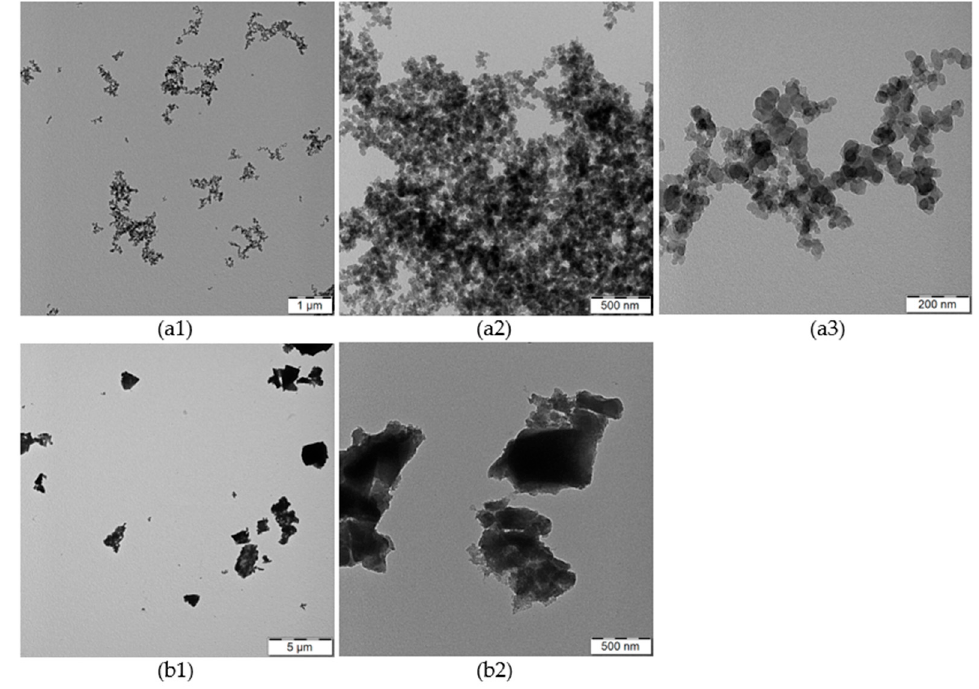
Figure 1. TEM images of carbon black ( a1 – a3 ) and hydrochar ( b1 – b2 ) at different